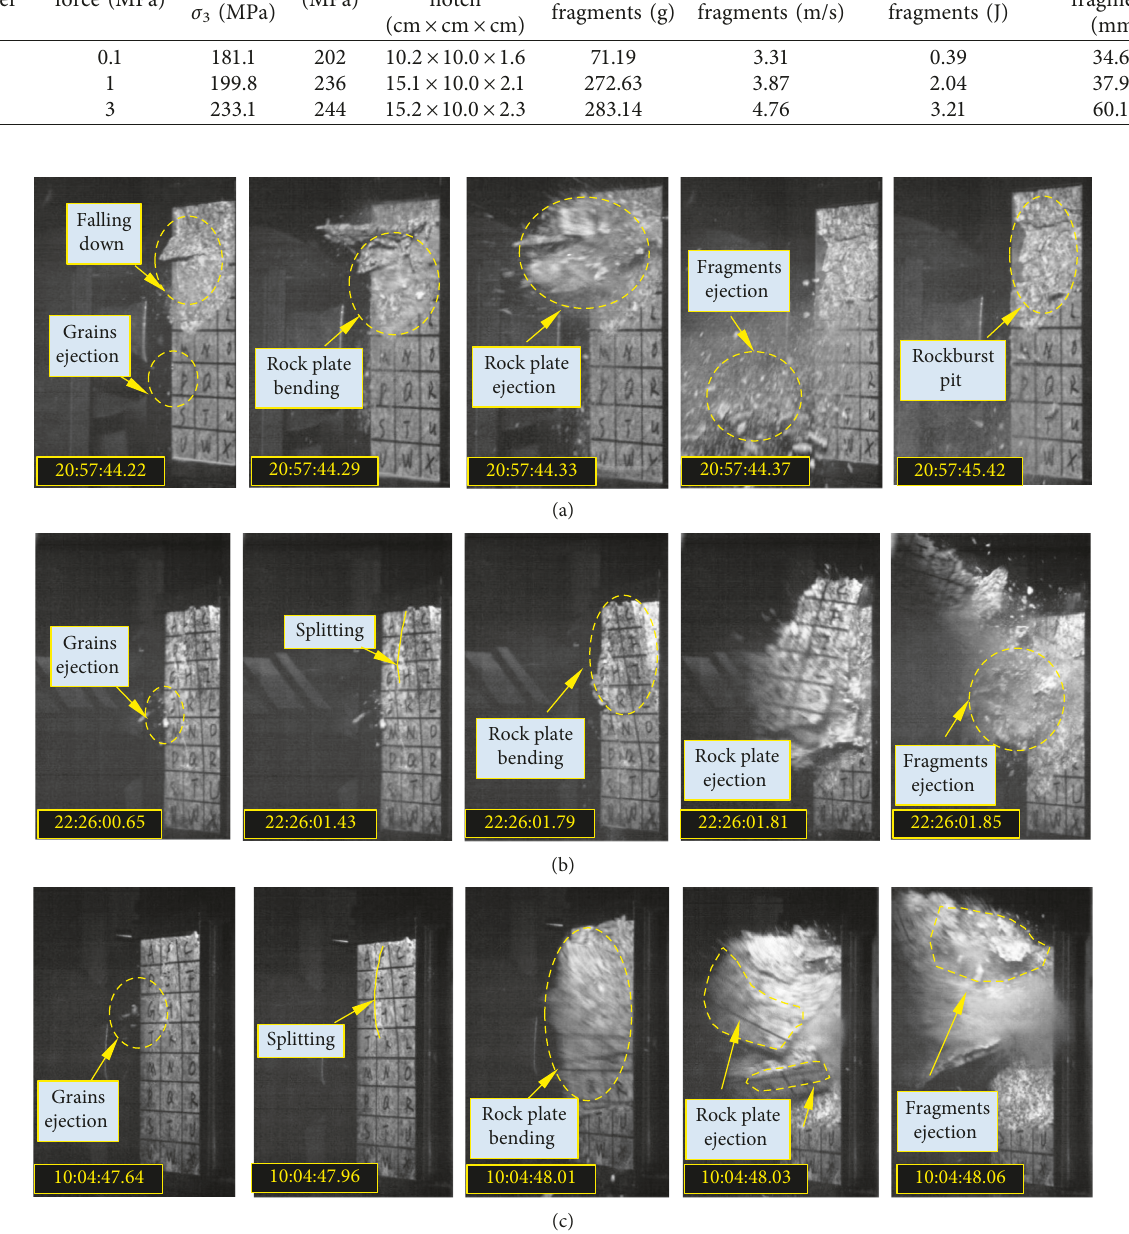
Table 4: Testing results of one-single face true-triaxial unloading test with different support forces.